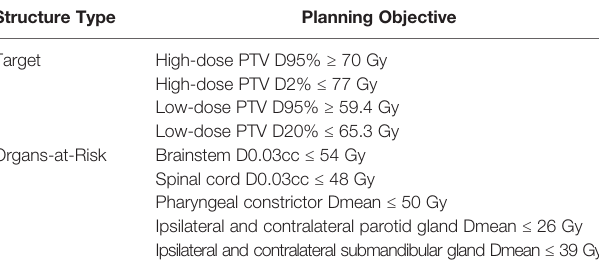
TABLE 1 | Radiotherapy treatment planning